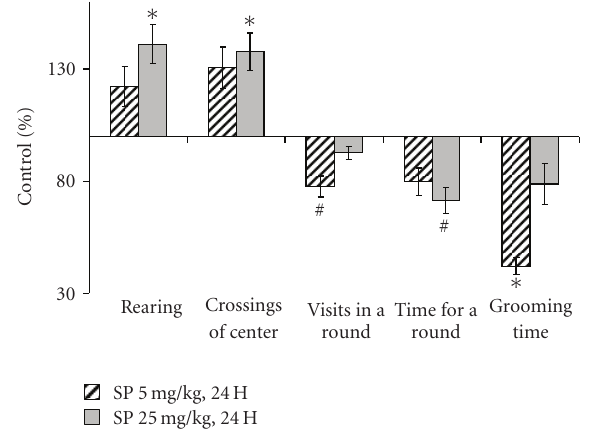
Figure 2: Changed behavioral parameters of male rats tested in the closed plus maze 24 hours after the treatment with 5 and 25 mg/kg SP. Statistical significance: ∗ P < . 05; # P ≤ . 1